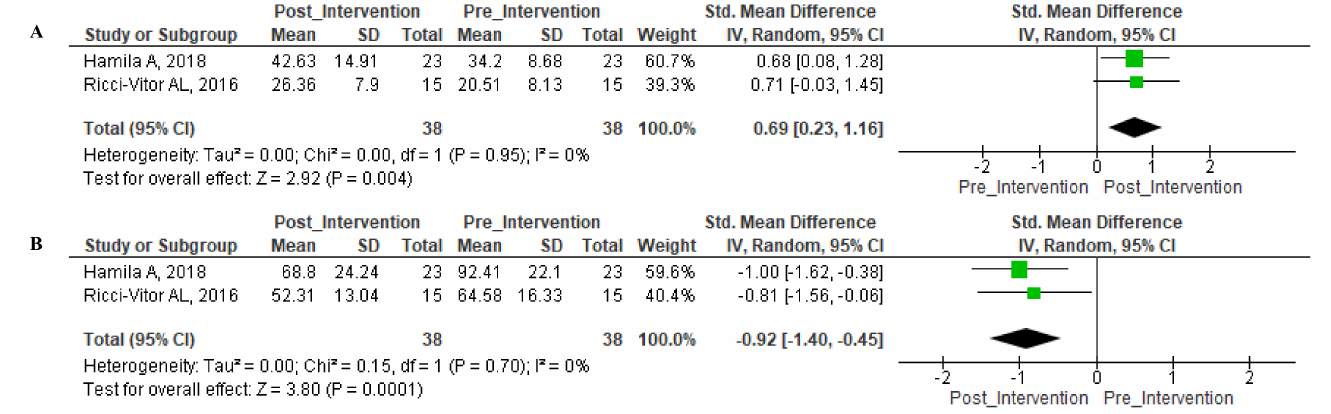
Figure 4. Forest Plot—Non-linear indices. Legend—( A ): SD1; ( B ): SD2. The secondary parameters were evaluated, and the forest plot was illustrated in Figure 5. In Figure 5A, the exercise offered a significant effect (Z = 2.80 ( p = 0.005)) in the reduction in BMI (kg/m 2 ) without significant heterogeneity. In the same way, Fat% demonstrated a significant change (Figure 5B) (Z = 2.84 ( p = 0.005)) but not a significant heterogeneity (I 2 = 87%; p <